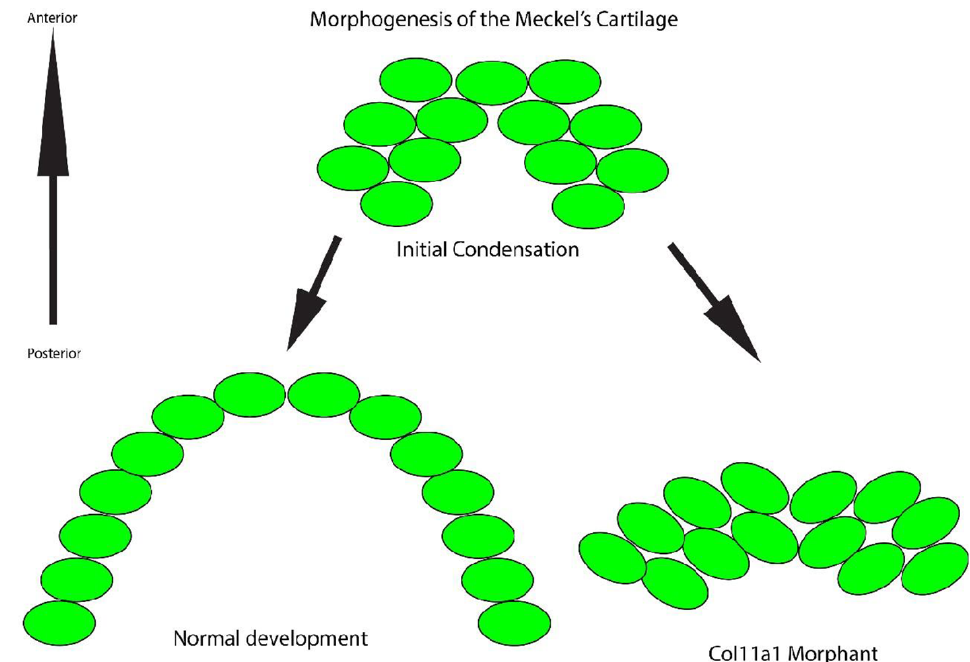
Figure 5. Model of Meckel’s cartilage development and the cellular organization in normal development and in the col11a1a morphant. During normal development, the cells (green) reorganize and form a single file stack of cells that promotes extension distally. In contrast, inhibition of col11a1a expression prevents reorganization into stacked cells. Therefore, the Meckel’s cartilage does not extend distally.